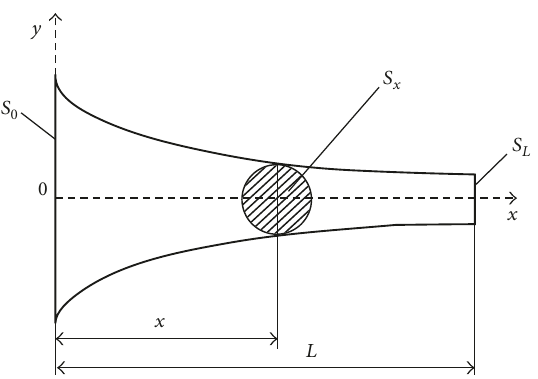
Figure 1: The solid horn